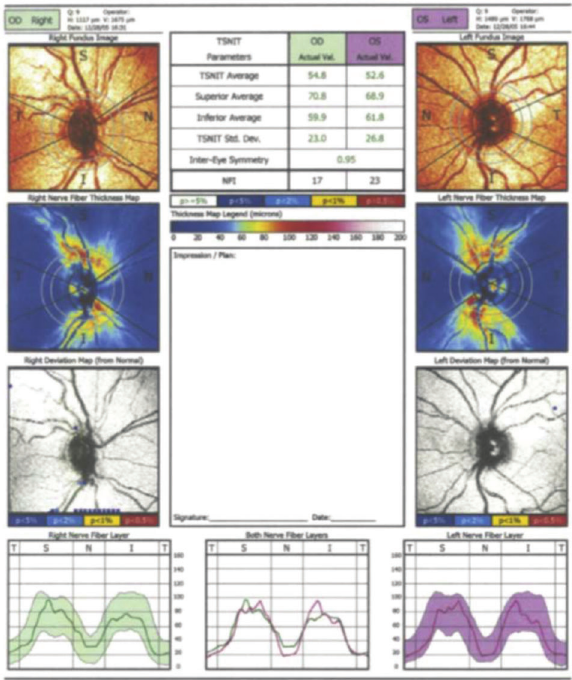
Figure 1 - Printout of the retinal nerve fiber layer (RNFL) analysis with scanning laser polarimetry (SLP) with variable corneal compensation (GDx